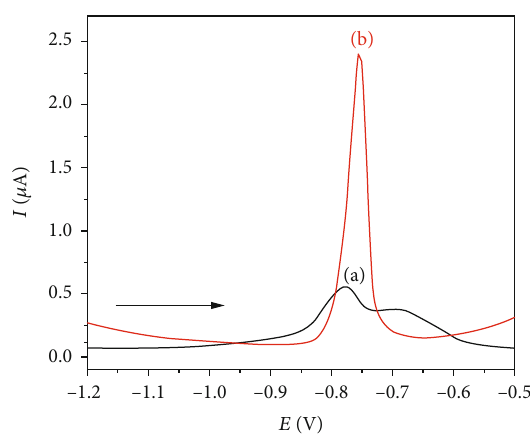
Figure 5: SWASV of 4.5 μ g · L -1 Pb 2+ in acetate bu ff er (pH4.5) at bare SPEs (a) and p(1,5-DAN)/SPEs (b). Deposition potential: -1.2 V; deposition time: